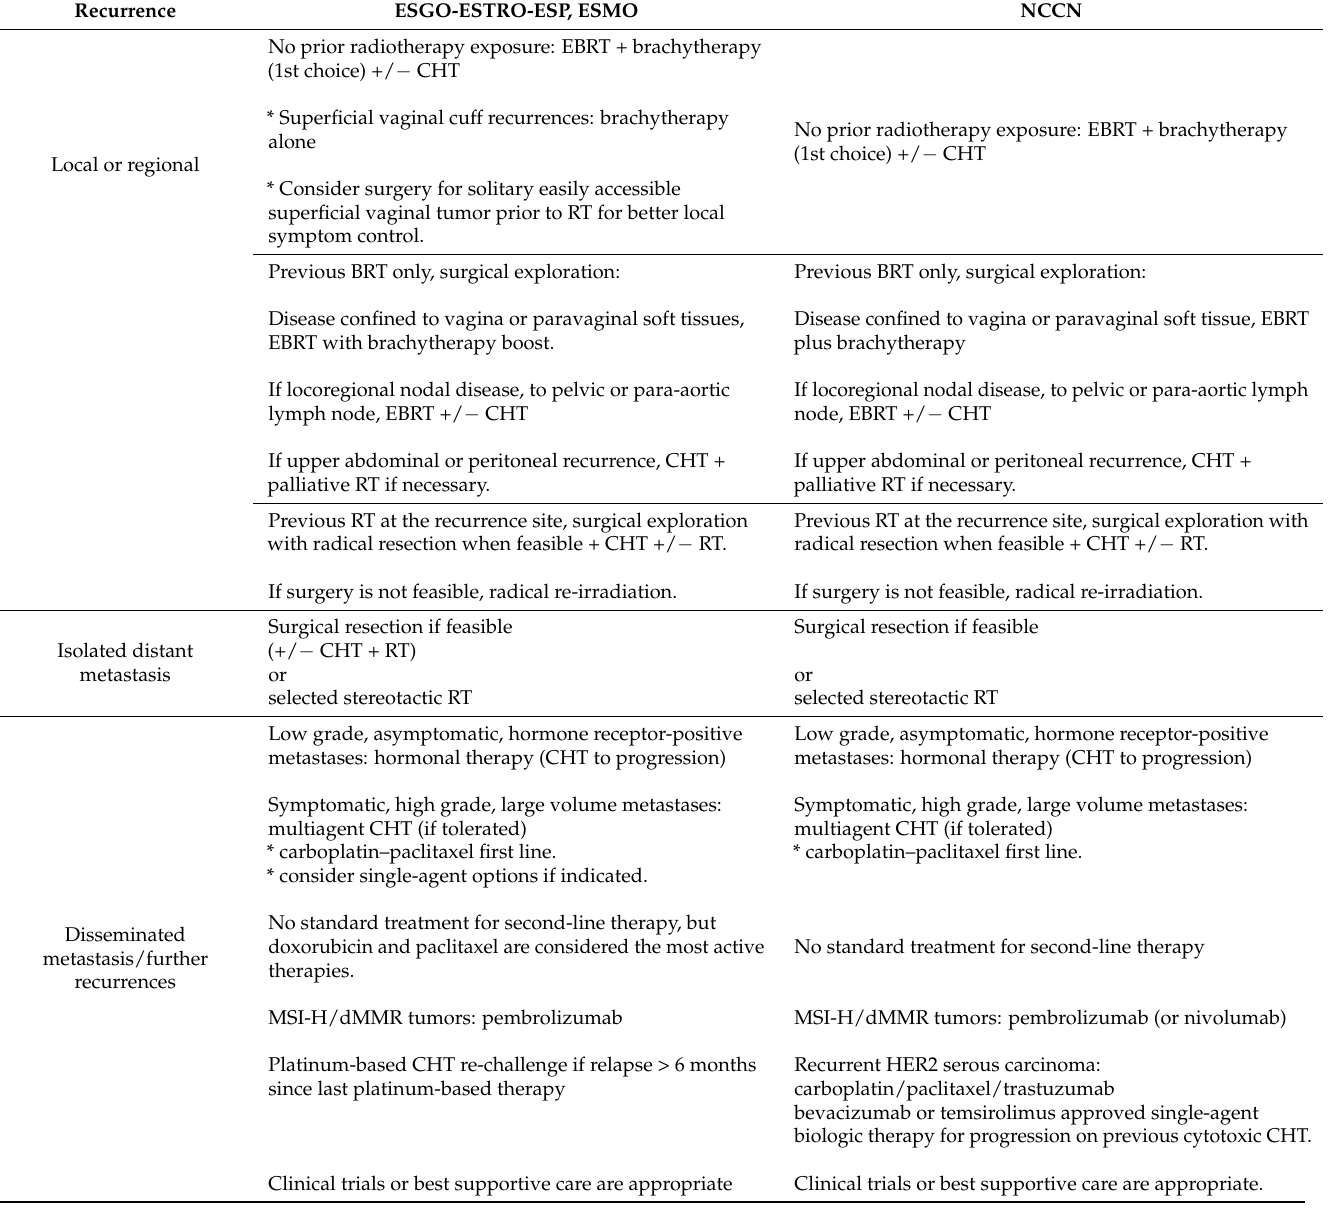
Table 3. Management of